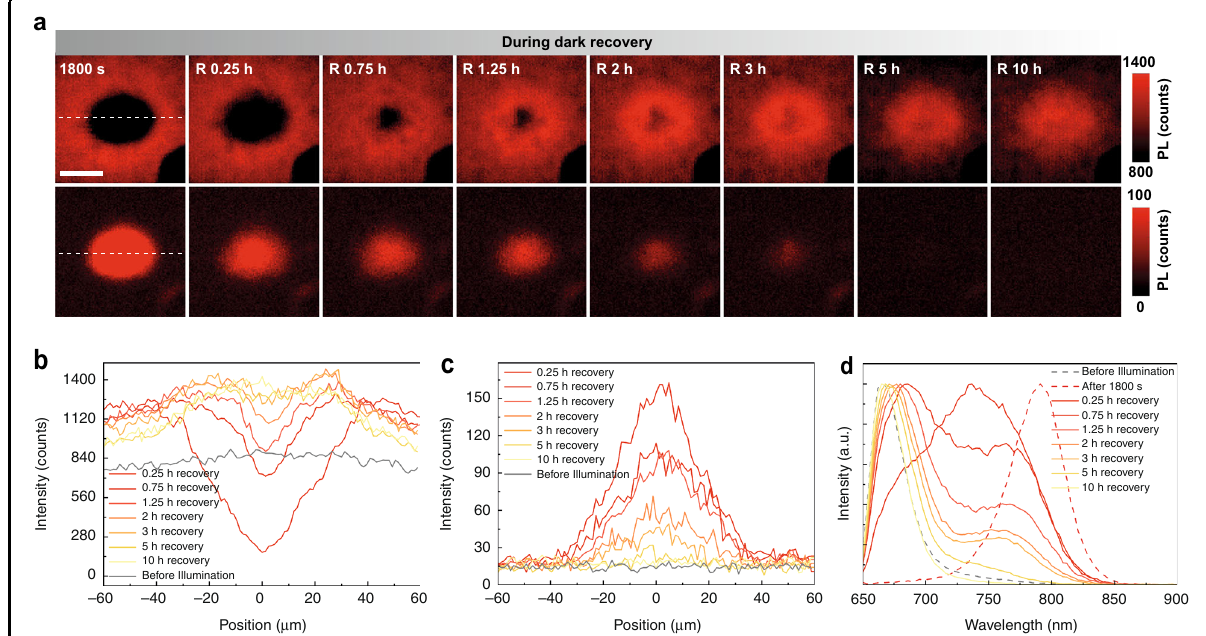
Fig. 2 The recovery process of the light-induced ion redistribution. a PL mapping at different recovery times for 670 nm (top row) and 790 nm (bottom row). The scale bar is 40 μ m. b , c Time-dependent PL spatial pro fi les taken at the white dashed lines in ( a ) for 670 and 790 nm, respectively. d Dynamic tracking of normalized PL spectra at the illuminated